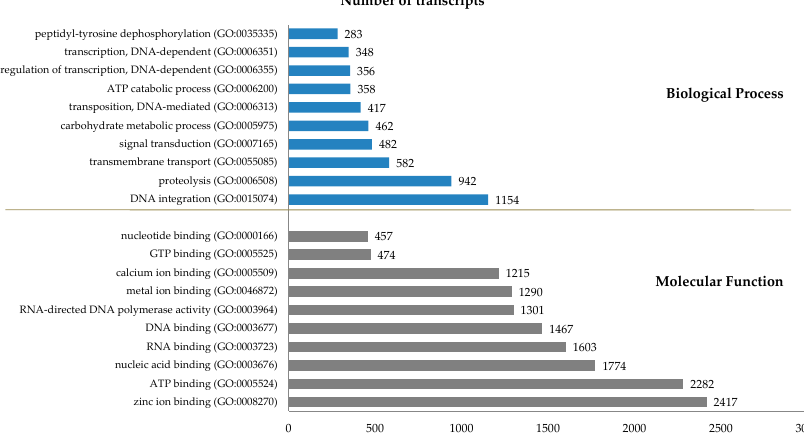
Figure 1. GO (Gene ontology) classification of the reference genes identified by transcriptome analysis of Pacific abalones. The top 10 GO terms and their proportions in the molecular function and biological process categories are shown.